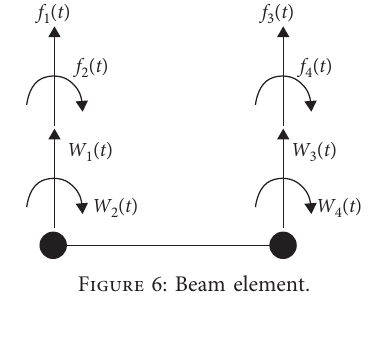
Figure 6: Beam element.